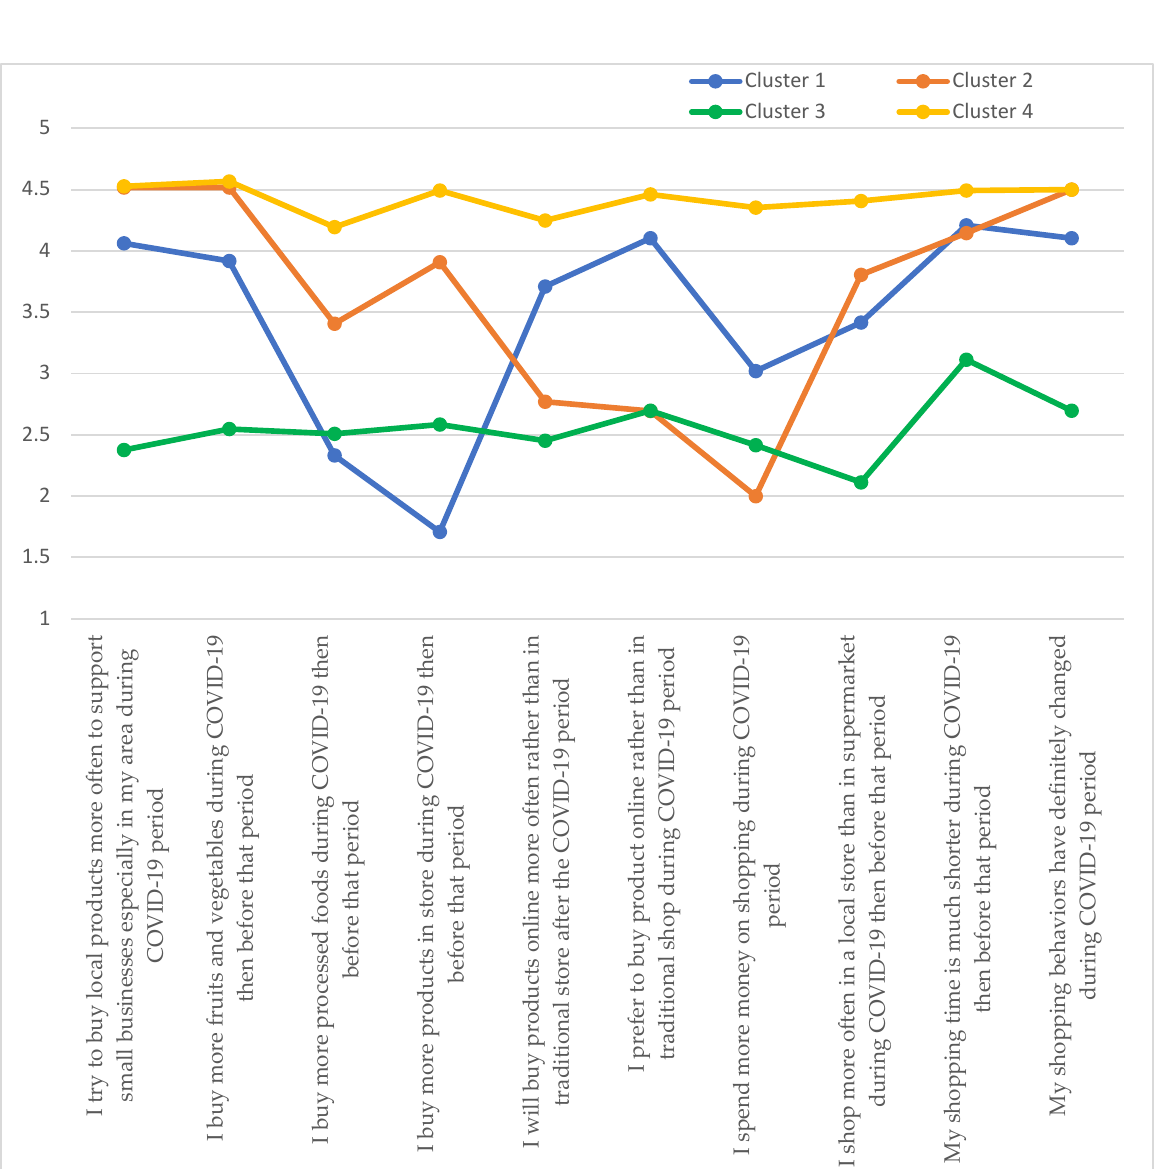
Figure 3. Cluster analysis: Asian students.